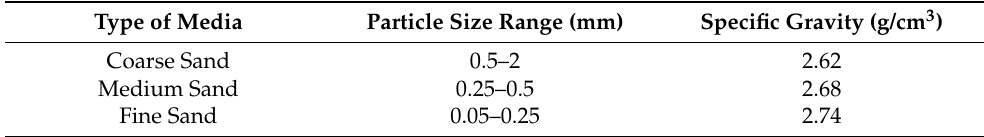
Table 1. Soil particle size and specific gravity.